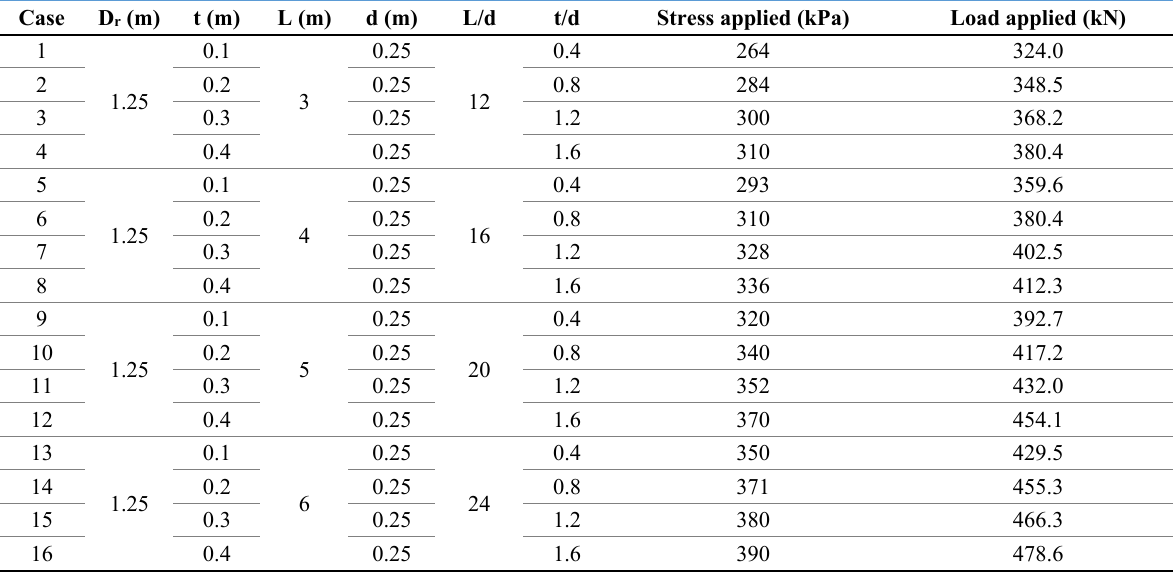
Table 2. Details of the piled raft geometries analyzed and their